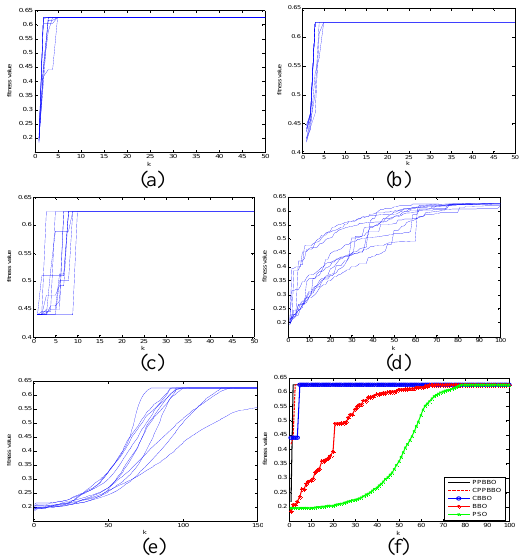
(f) Fig.7.Comparative results for case 2. (a)Evolution curves of PPBBO;(b) Evolution curves by of CPPBBO;(c)Evolution curves of CBBO;(d) Evolution curves of BBO;(e) Evolution curves of PSO;(f). Evolution curves in comparison.